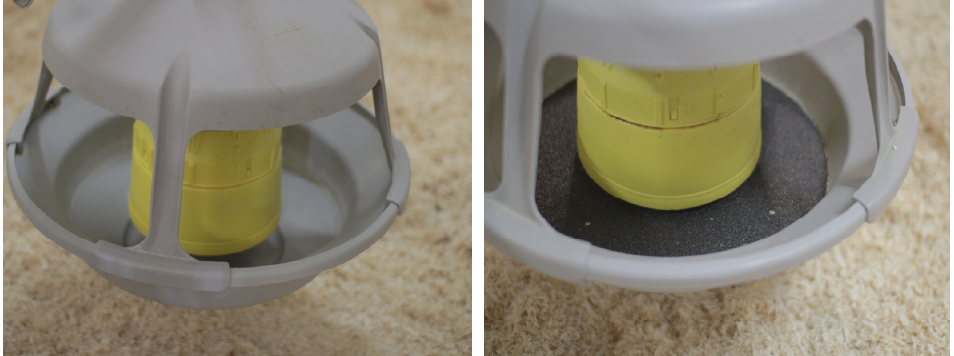
Figure 2. Feed pan without the blunting disk on the left side and with the integrated 30-grit screed grinding wheel on the right side.